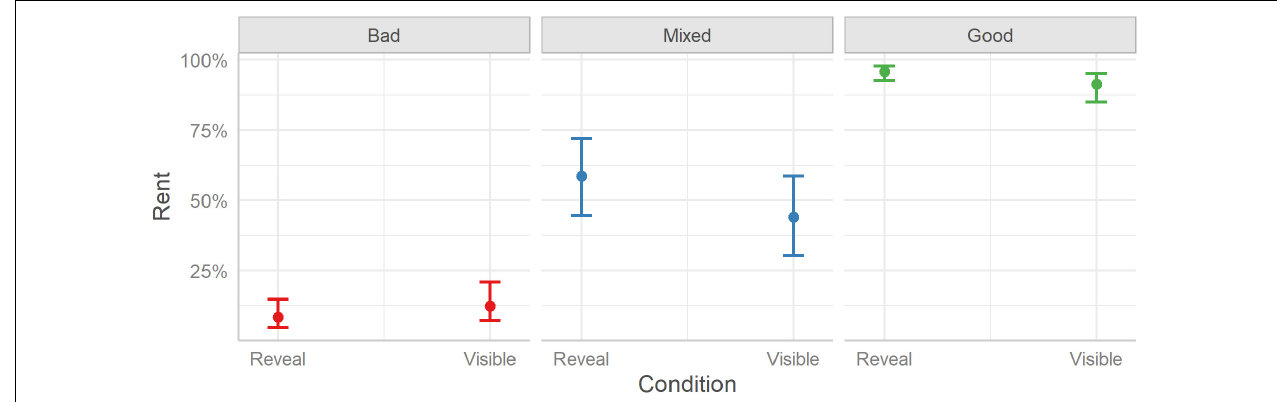
FIGURE 2 | The probabilities of deciding to rent a room between the two experimental conditions (Reveal and Visible) split over the three Profile conditions (Bad, Mixed, and Good). Error bars indicate 95% credible intervals.